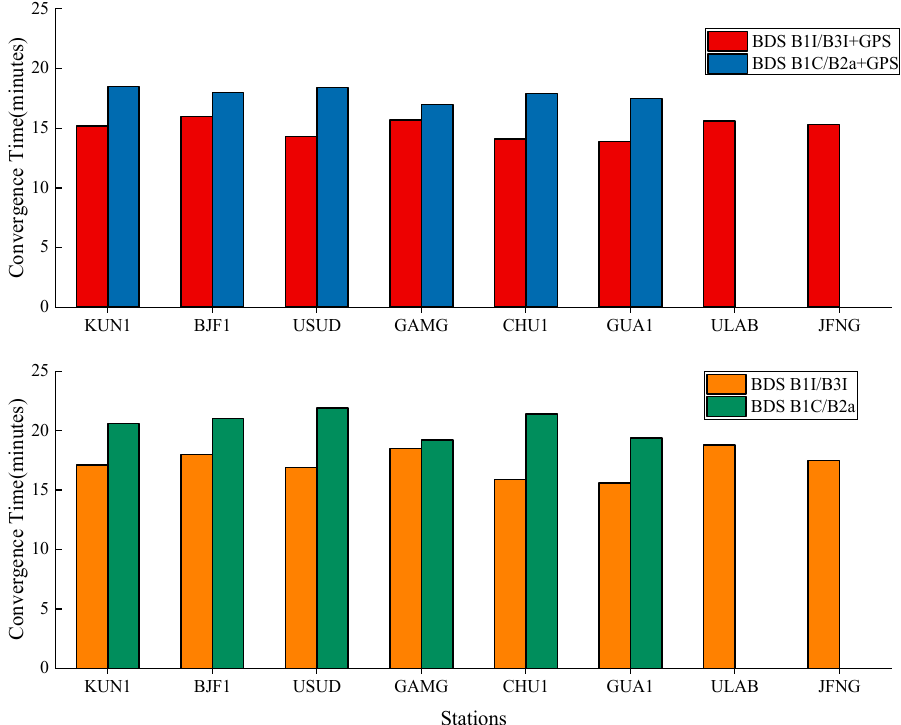
Figure 4. Average convergence time from DoY 67 to 76 and from 85 to 96 in 2022.